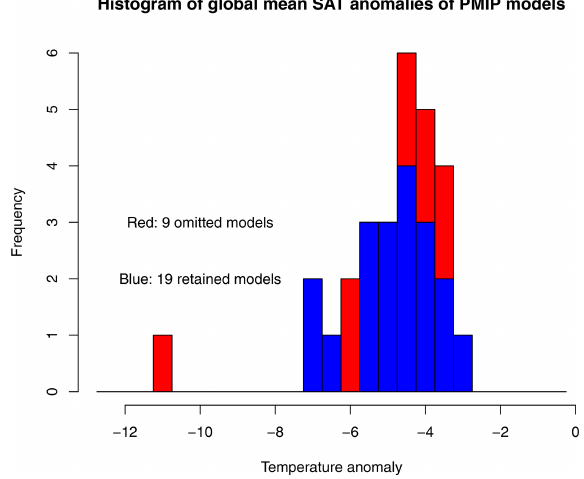
Figure 1. Histogram of global mean surface air temperature of PMIP models. Blue shows retained models. Red shows omitted